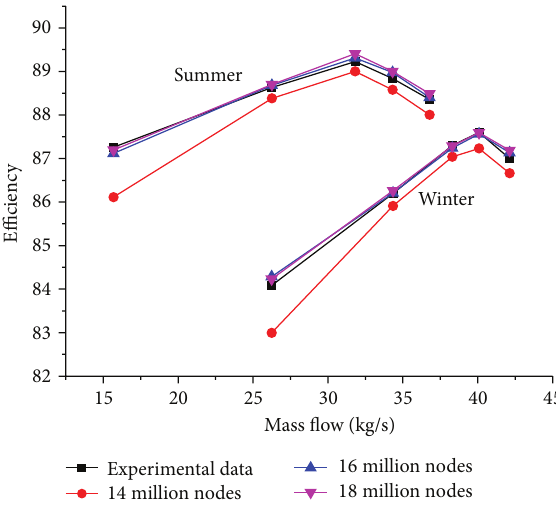
Figure 4: Comparison of efficiency curve in different number of grid nodes and experimental